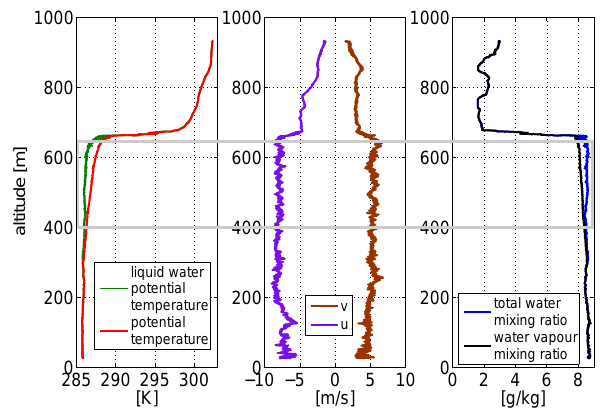
Fig. 3. As in Fig. 2, but for flight TO13.